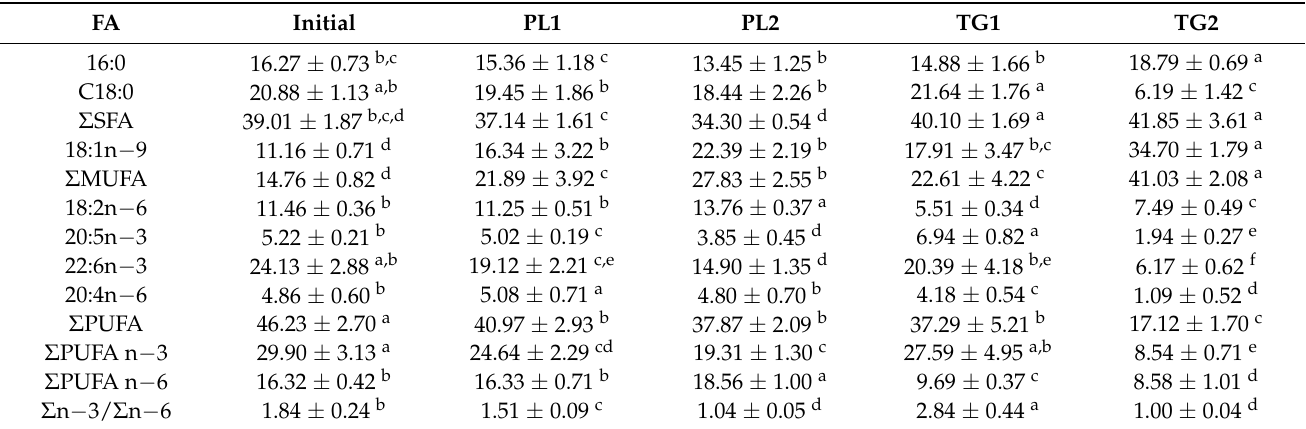
Table 6. Fatty acid percentages of the polar fractions of the livers of dusky grouper juveniles fed the experimental